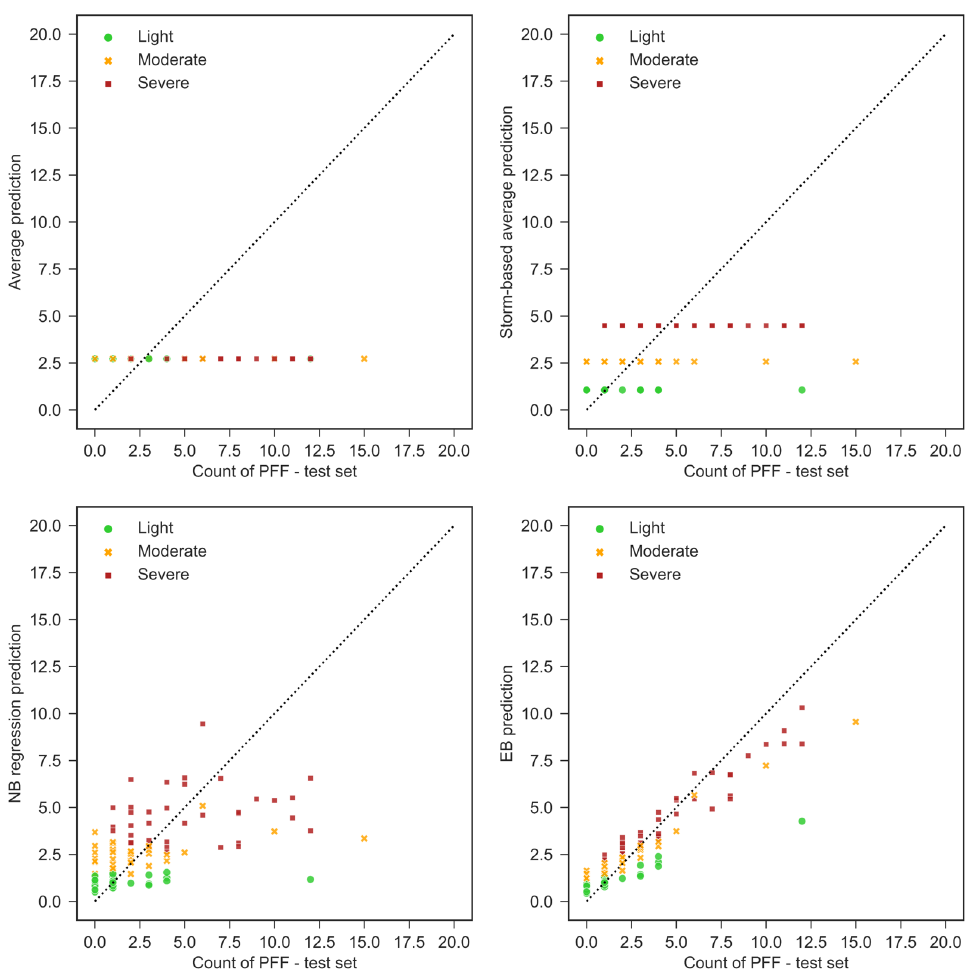
Figure 13. Prediction of the number of PFF using benchmark models and EB. Table 5. Summary performance of